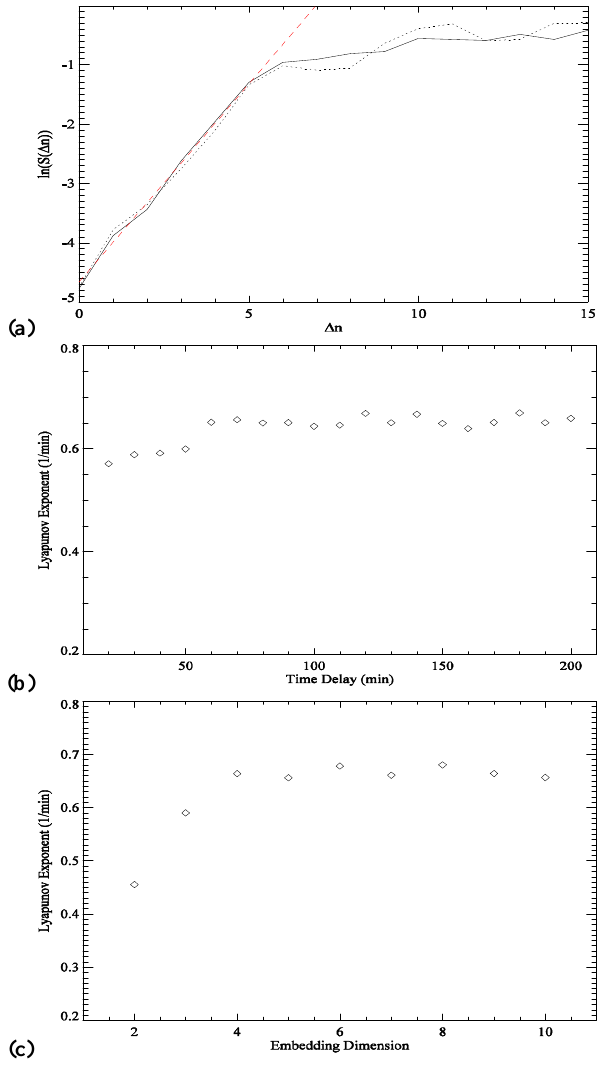
Figure 3c Fig. 3. Plots of (a) the curves of ln( S ( 1 n )) for embedding dimen- sions m =5 and 6 (continuous and dotted lines respectively), with τ =70, Theiler window ( ω )=380, whose slope will give the Lya- punov exponent, (b) the variation of Lyapunov exponent with time delay by keeping embedding dimension a constant, and (c) the vari- ation of Lyapunov exponent with embedding dimensions by keep- ing time delay a constant, for the time series of AE index, during the quiet period, 5–11 January